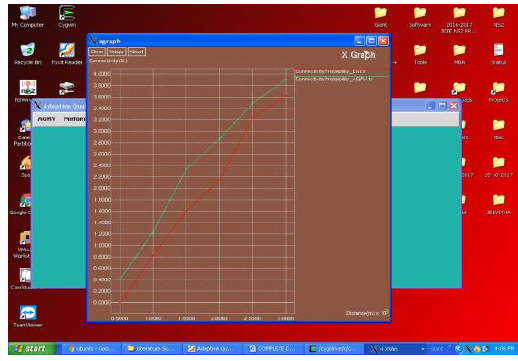
Figure 10: Packet Delivery Ratio and